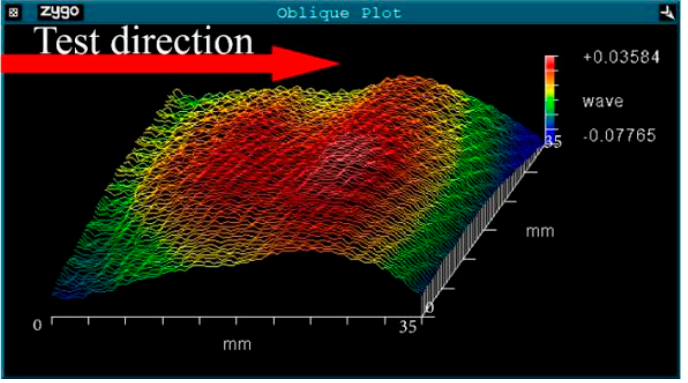
Figure 9. Surface shape test result.